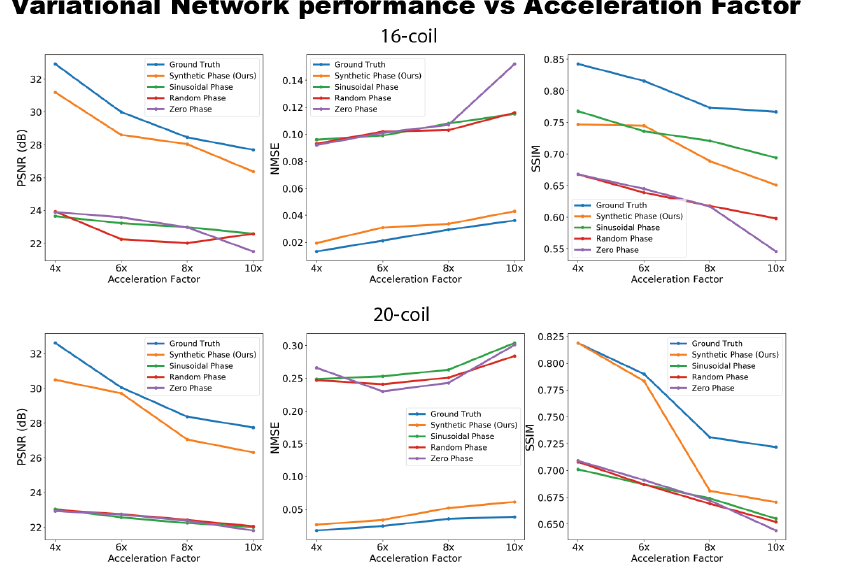
Figure 5. Performance of ground truth-trained and synthetically trained Variational Network re- construction models at different acceleration factors for 16-coil and 20-coil datasets. At up to 10 × acceleration factors, synthetically trained models show comparable performance to ground-truth trained models. These data are also shown in tables in the Supplementary